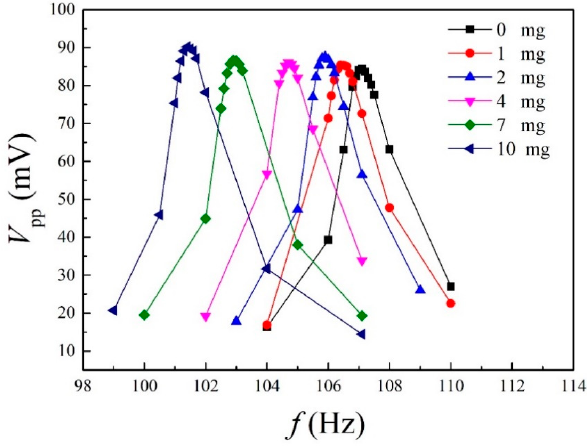
Figure 3. Measured output voltage versus frequency. Table 4. Comparison of the output voltage densities of magnetostrictive cantilevers under bending